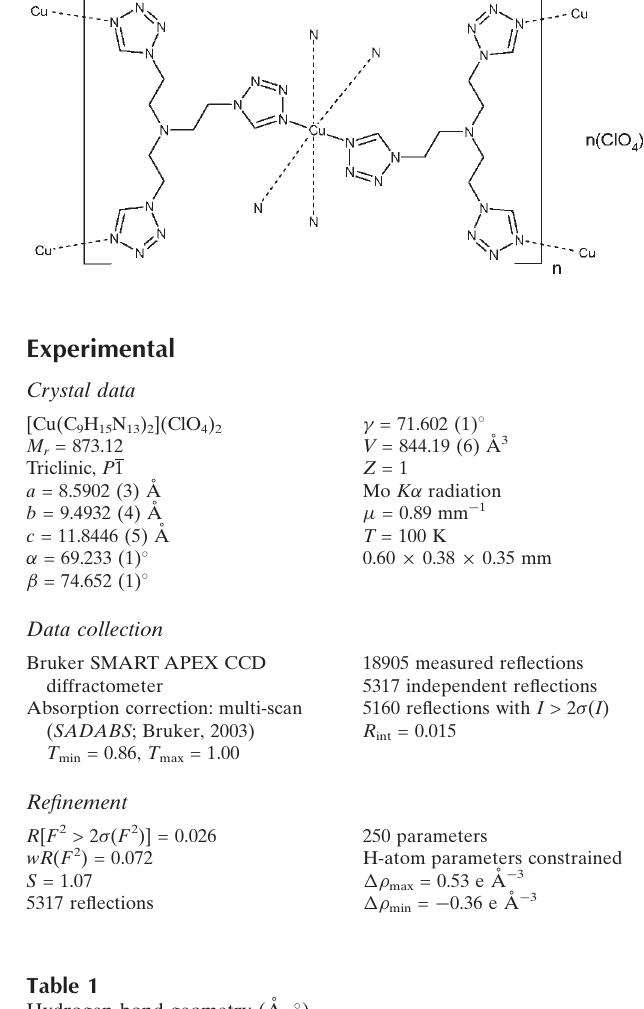
Hydrogen-bond geometry (A˚ , (cid:3)